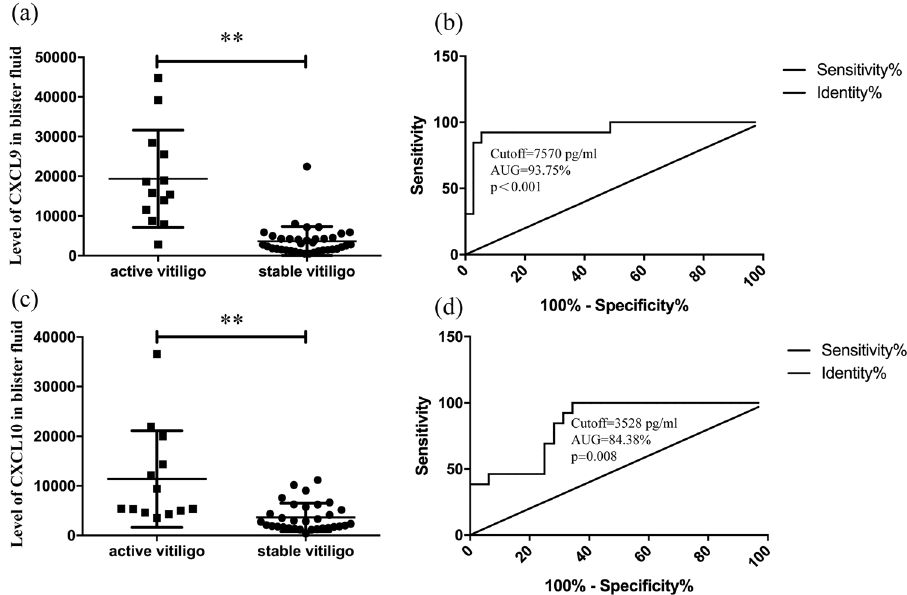
Figure 3. ( a , c ) The levels of CXCL9 and CXCL10 in blister fluid. ( b , d ) ROC curves plotted to distinguish the cut-off values of CXCL9 andCXCL10 among active patients and stable vitiligo patients. *P < 0.05, **P < 0.01.